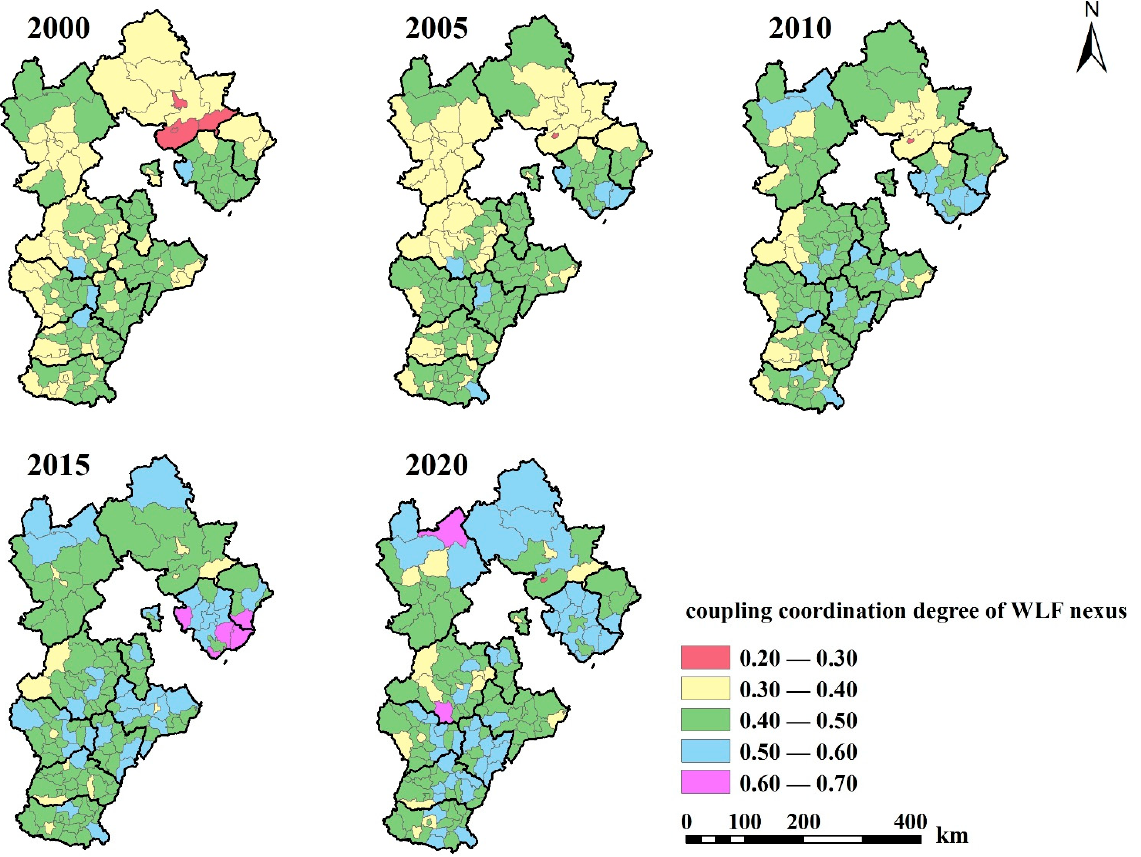
Figure 5. The degree of coupling coordination of the WLF nexus system in 151 counties of Hebei Province.